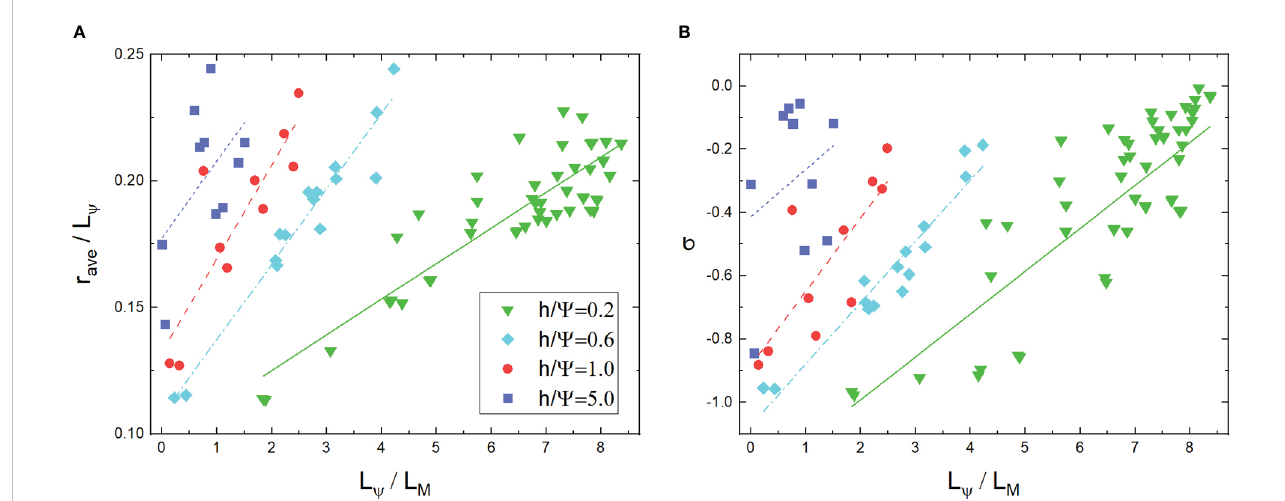
FIGURE 8 (A) r ave / L y vs L y / L M from the eigenmodes with low frequency whose s <0. (B) s vs L y / L M from the eigenmodes with lower frequency whose s <0 . y =